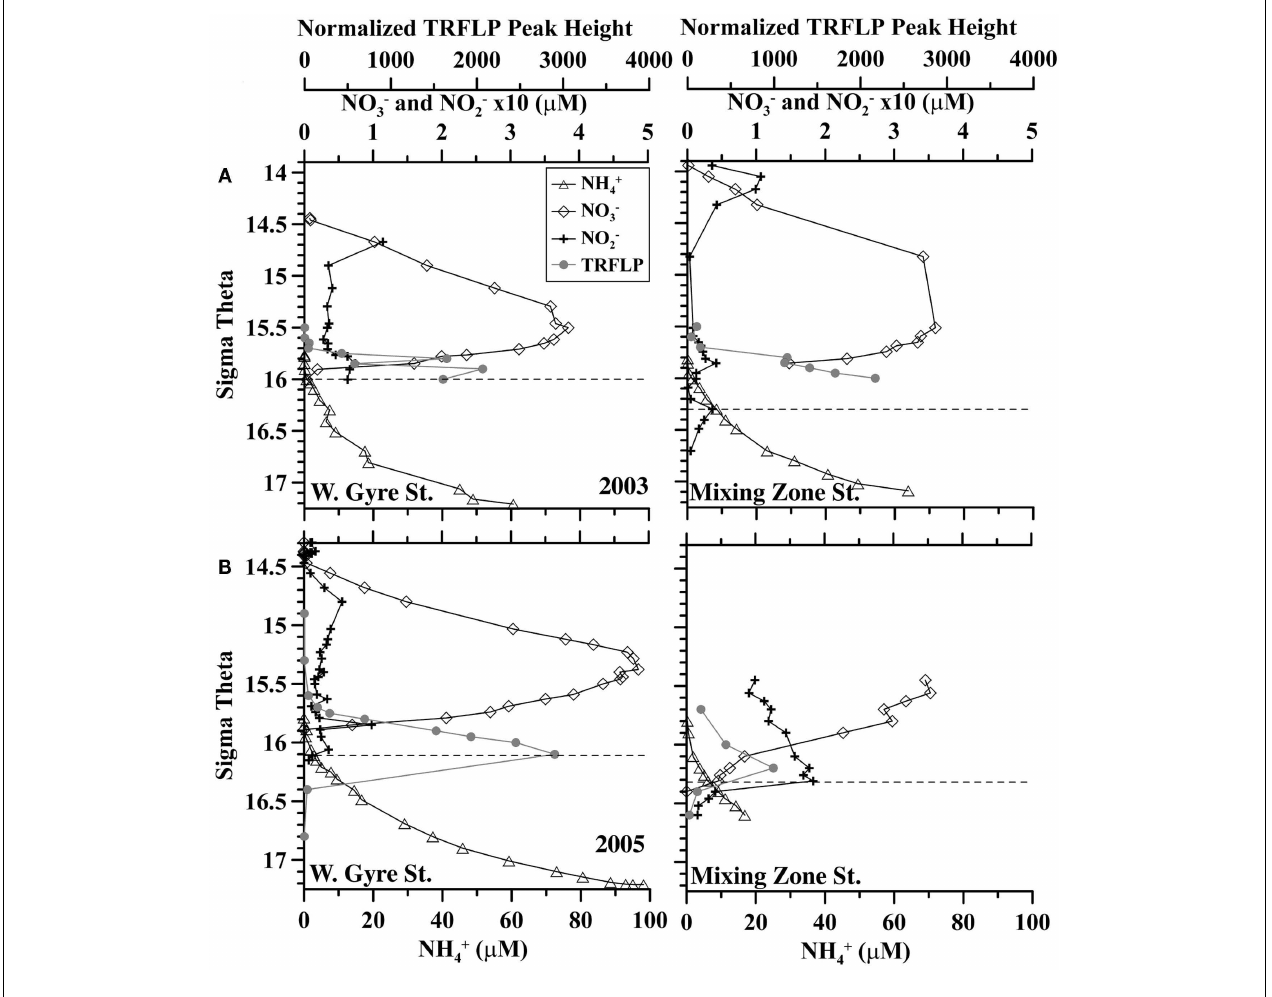
FIGURE 3 | Comparison of nitrate (diamonds), nitrite (crosses), ammonium (triangles), and Scalindua normalizedTRFLP peak height (gray circles) between theWestern Central Gyre and Mixing